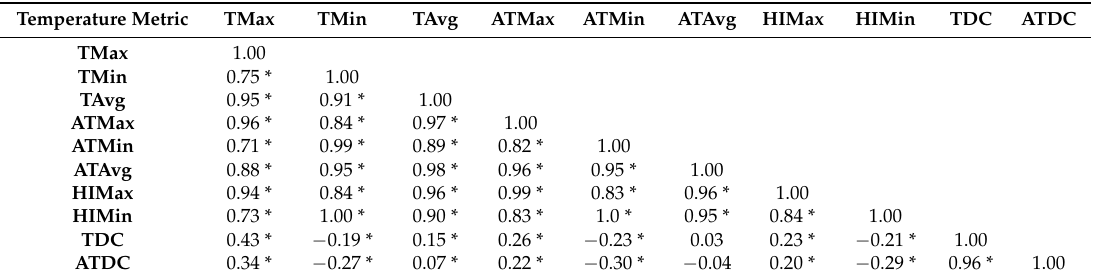
Table 2. Spearman correlations between various temperature metrics in Atlanta during the warm seasons (May–September), 1993–2012 ( n = 3060